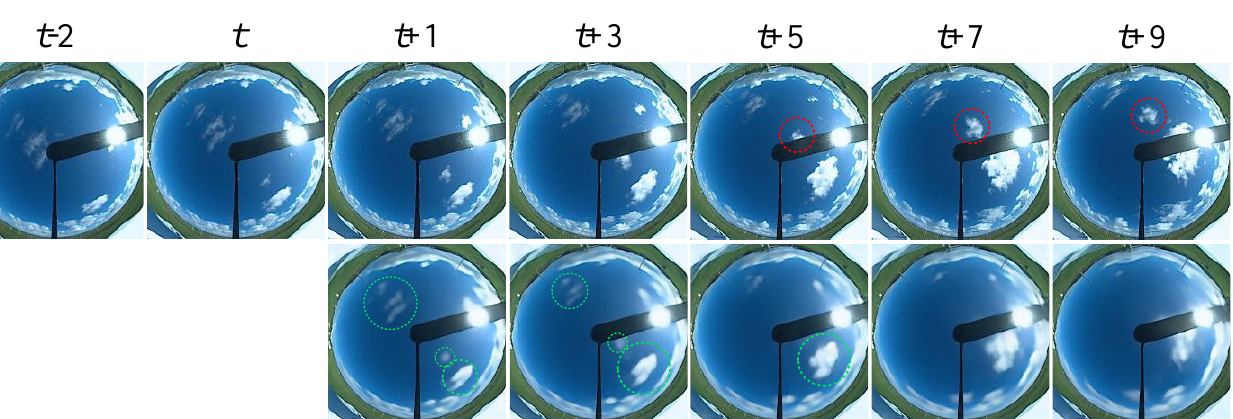
Table 3. PSNR (dB) and SSIM of the results in the test set .